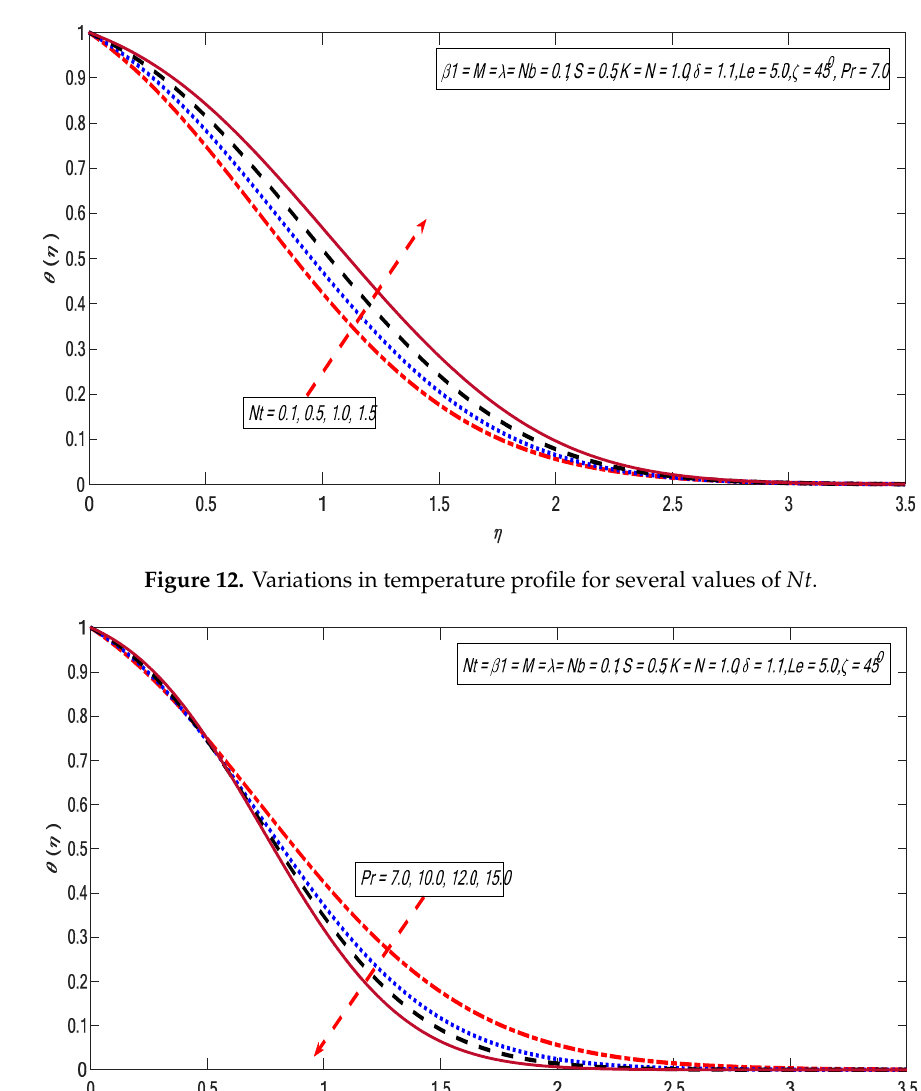
Figure 13. Variations in temperature profile for several values of 𝑃𝑟 .